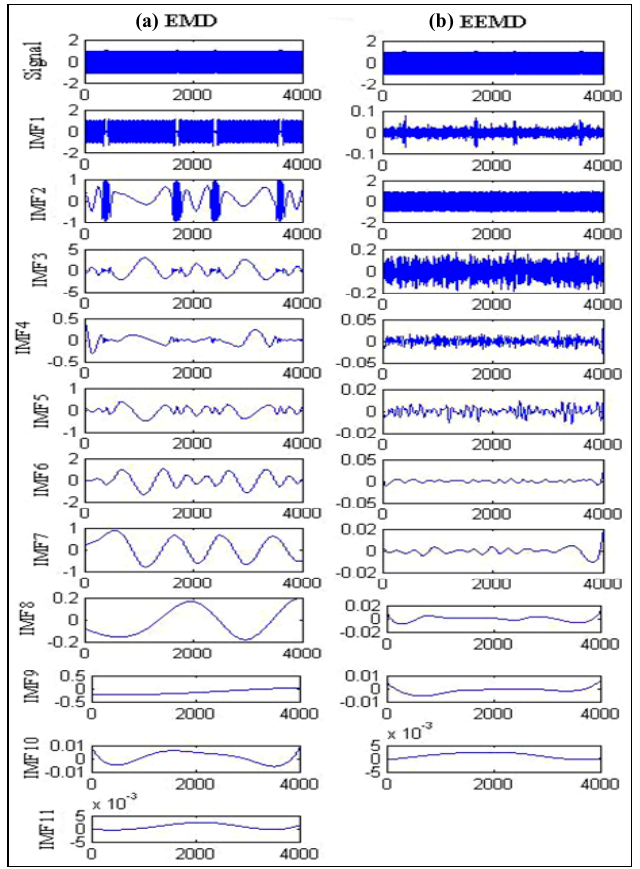
Figure 2. Decomposition results of ( a ) EMD and ( b ) EEMD (AR = 0.05, SFR = 2.35).